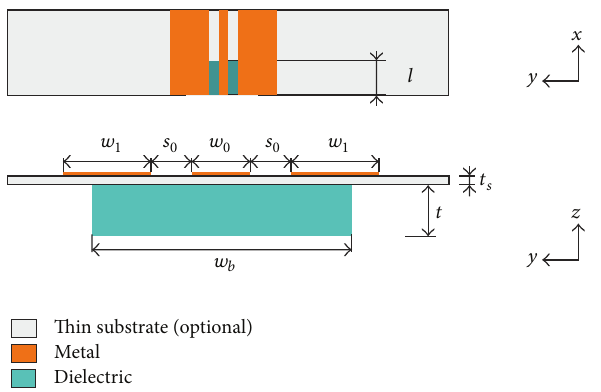
Figure 1: Geometry of the feeding line.